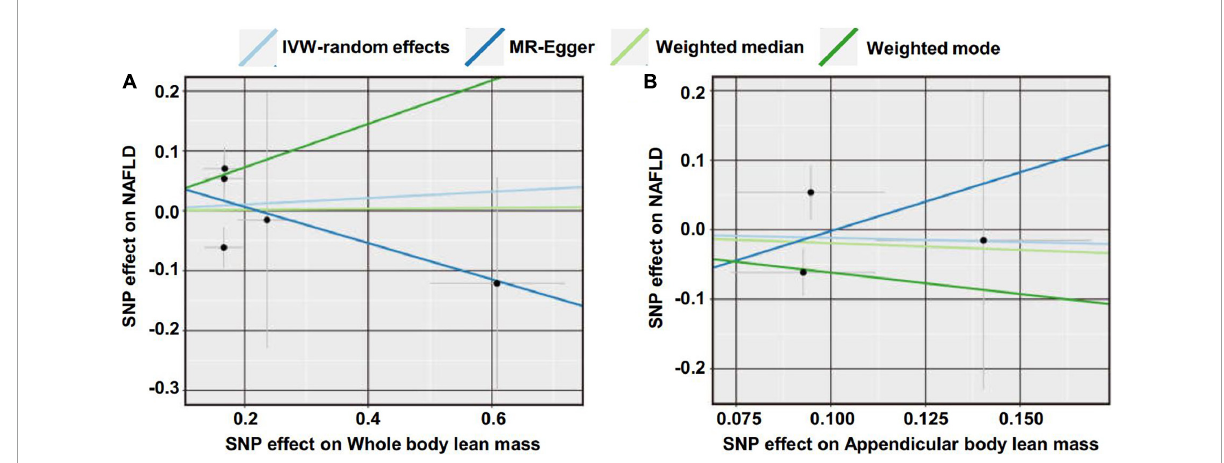
FIGURE2 Scatter plot of the causal effect of lean body mass on NAFLD using different MR methods. (A) Causal effect of whole body lean mass on NAFLD. (B) Causal effect of appendicular lean mass on NAFLD.